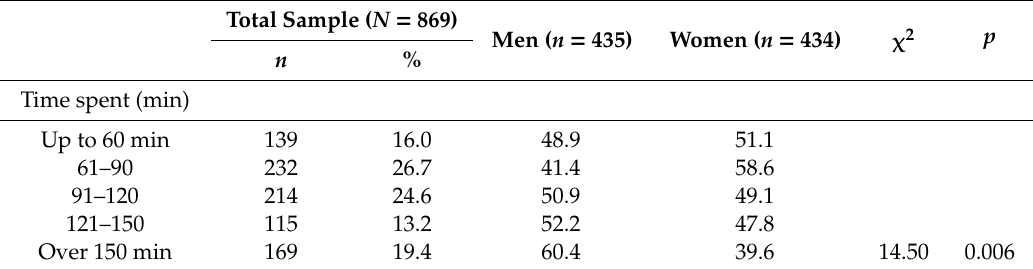
Table 1. Time spent on leisure activities. Prevalence according to gender. Total Sample ( N = 869)